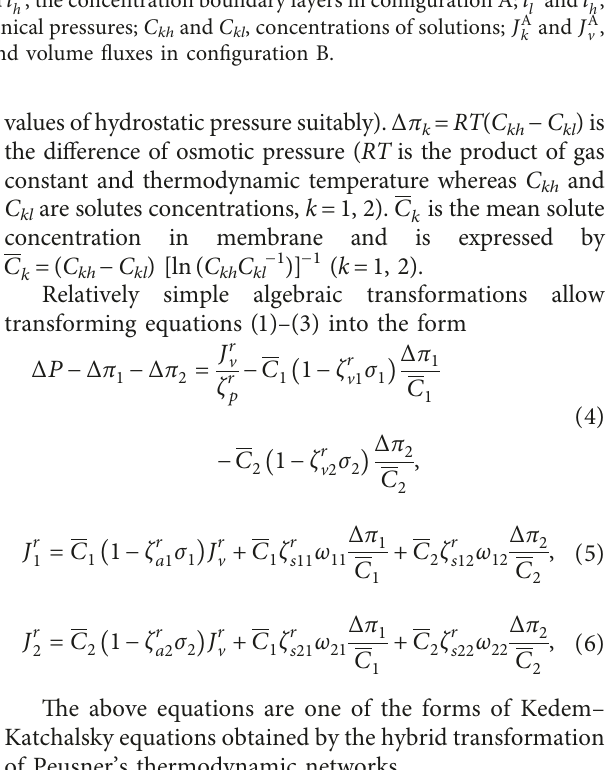
l B l B l and h ,